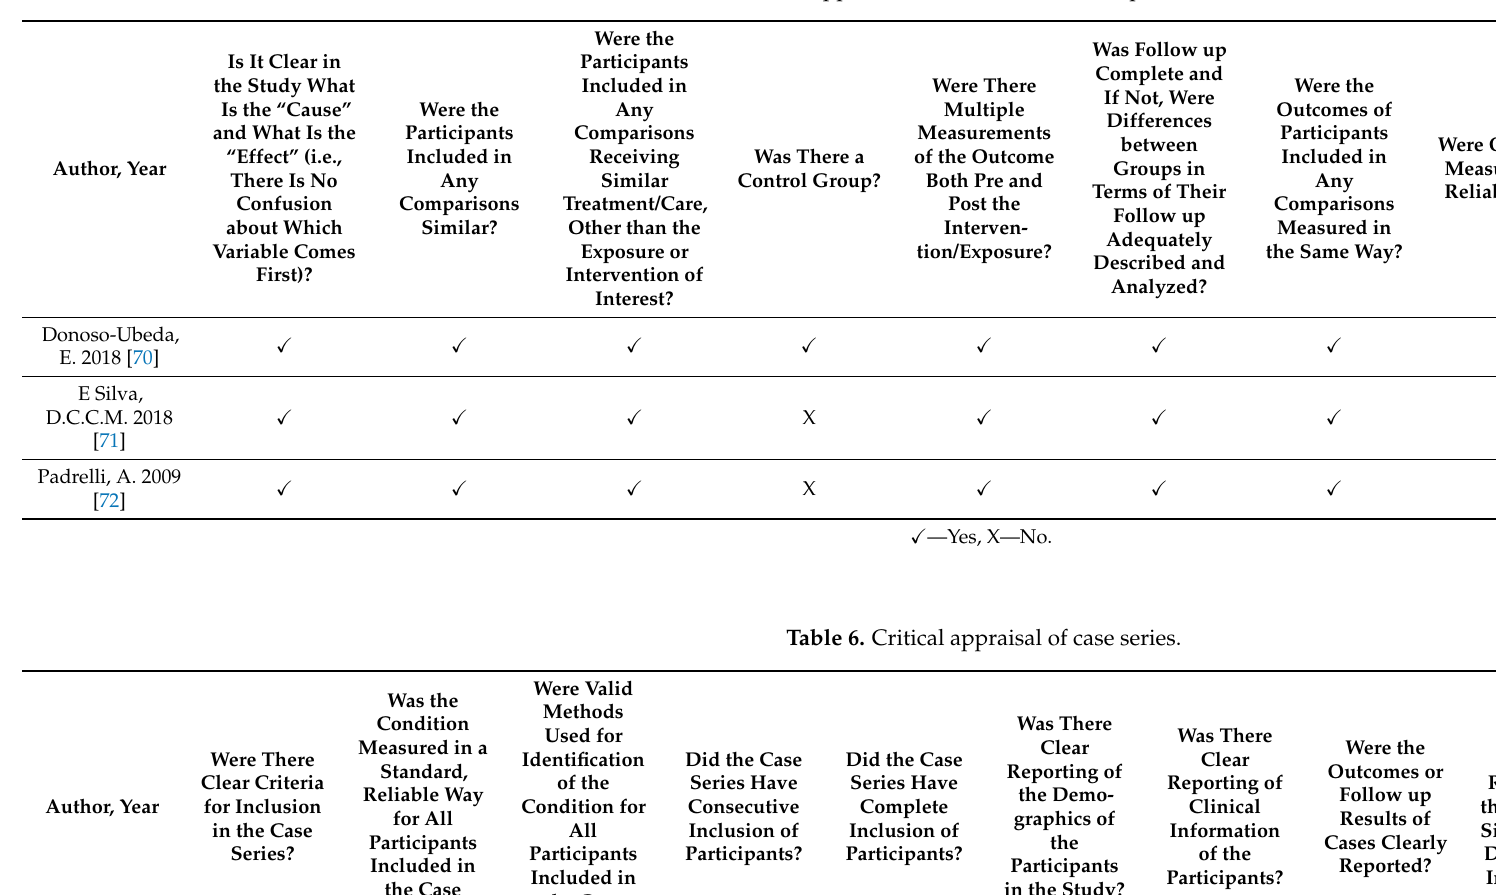
Table 5. Critical appraisal of non-randomized experimental studies.